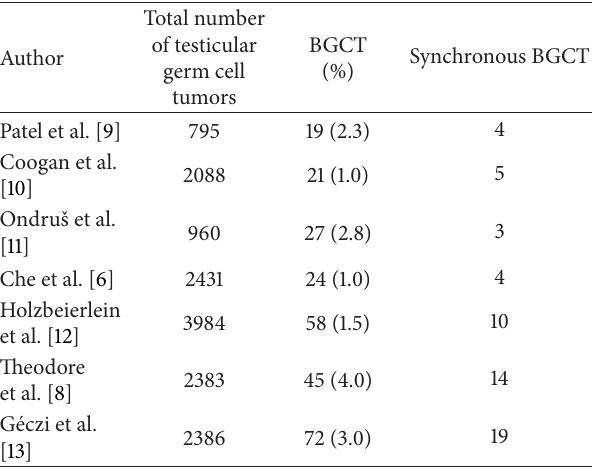
Table 1: Incidence of BGCT in selected